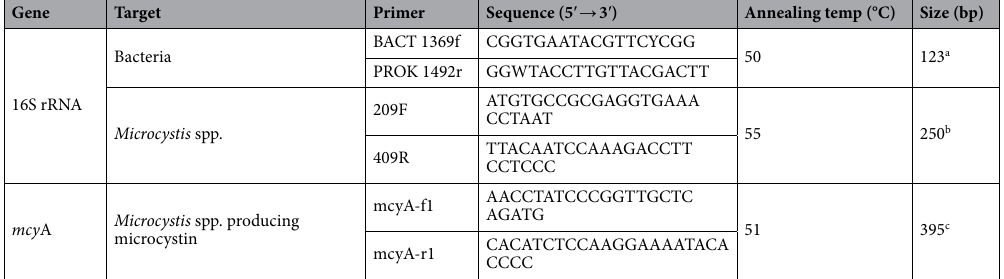
Table 2. Primers used for qPCR analysis in the present study. a Suzuki et al. 74 ; b Neilan et al. 75 ; c Gągała et al. 69